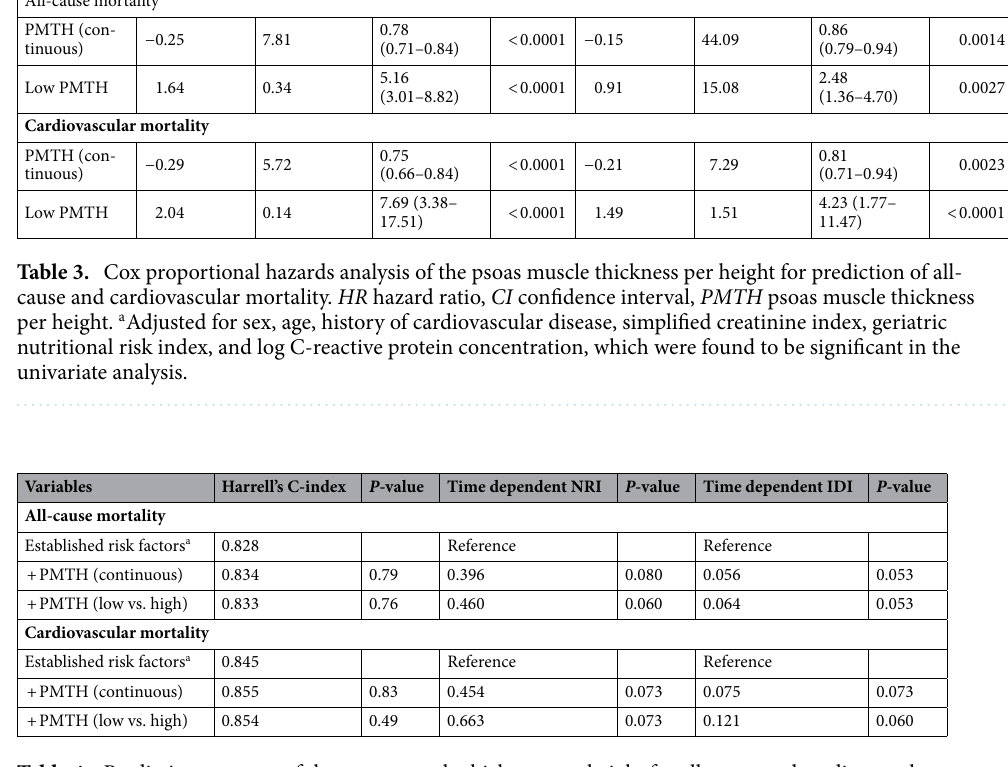
Table 4. Predictive accuracy of the psoas muscle thickness per height for all-cause and cardiovascular mortality using Harrell’s C-index for Cox hazard model, time dependent NRI and time dependent IDI. NRI net reclassification improvement, IDI integrated discrimination improvement, PMTH psoas muscle thickness per height. a Sex, age, a history of cardiovascular disease, simplified creatinine index, geriatric nutritional risk index, and log C-reactive protein